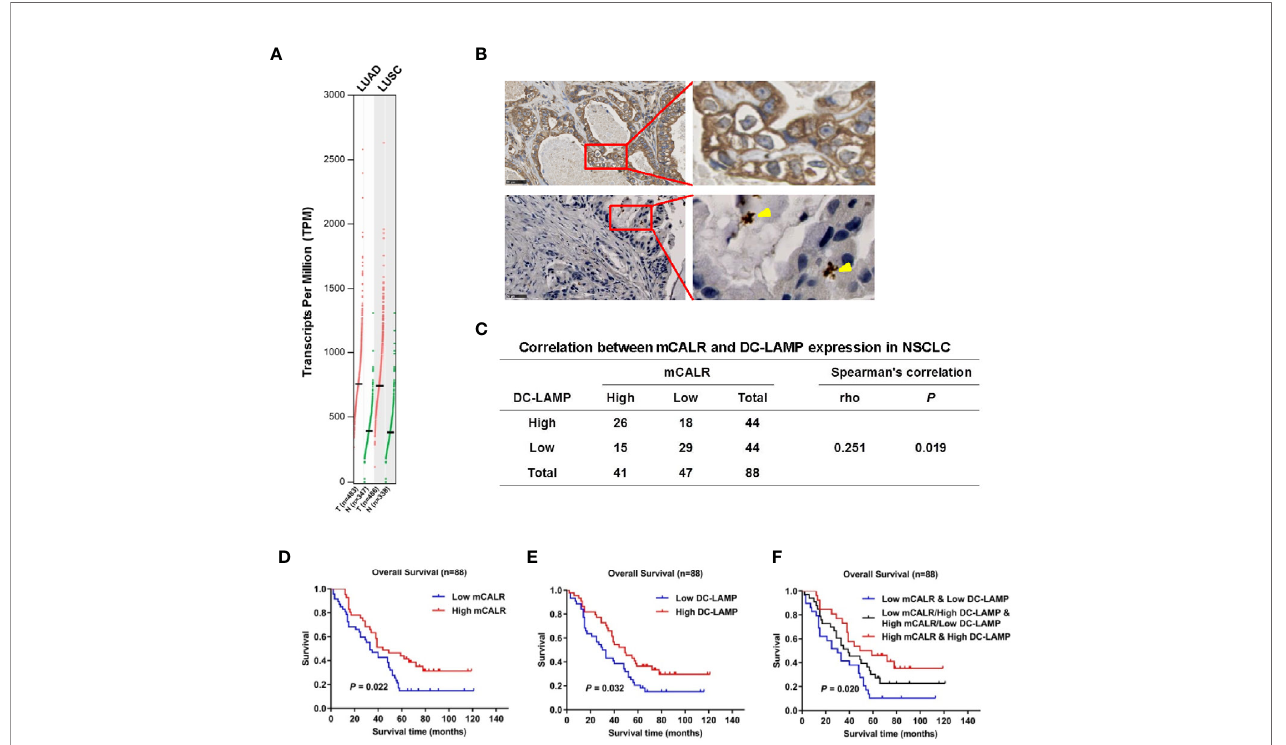
FIGURE 1 | Expression of mCALR and DC in fi ltration in NSCLC are positively correlated and are closely related with the prognosis of NSCLC patients. (A) The expression of CALR in NSCLC (LUAD and LUSC) tissues and normal tissues was analyzed using GEPIA. (B) The expressions of CALR and DC-LAMP in NSCLC tissues were determined by immunohistochemical staining; scale bar, 50 m m. (C) The correlation between mCALR and DC-LAMP expression in NSCLC, 88 samples were evaluated by IHC, high DC-LAMP samples, n=44; low DC-LAMP samples, n=44; high mCALR samples, n=41; low mCALR samples, n=47; Spearman ’ s correlation=0.251, P =0.019. (D) Overall survival rates of patients with high and low mCALR; P =0.022. (E) Overall survival rates of patients with high and low DC- LAMP; P =0.032. (F) Overall survival rates of patients with combined expression of mCALR and DC-LAMP; P